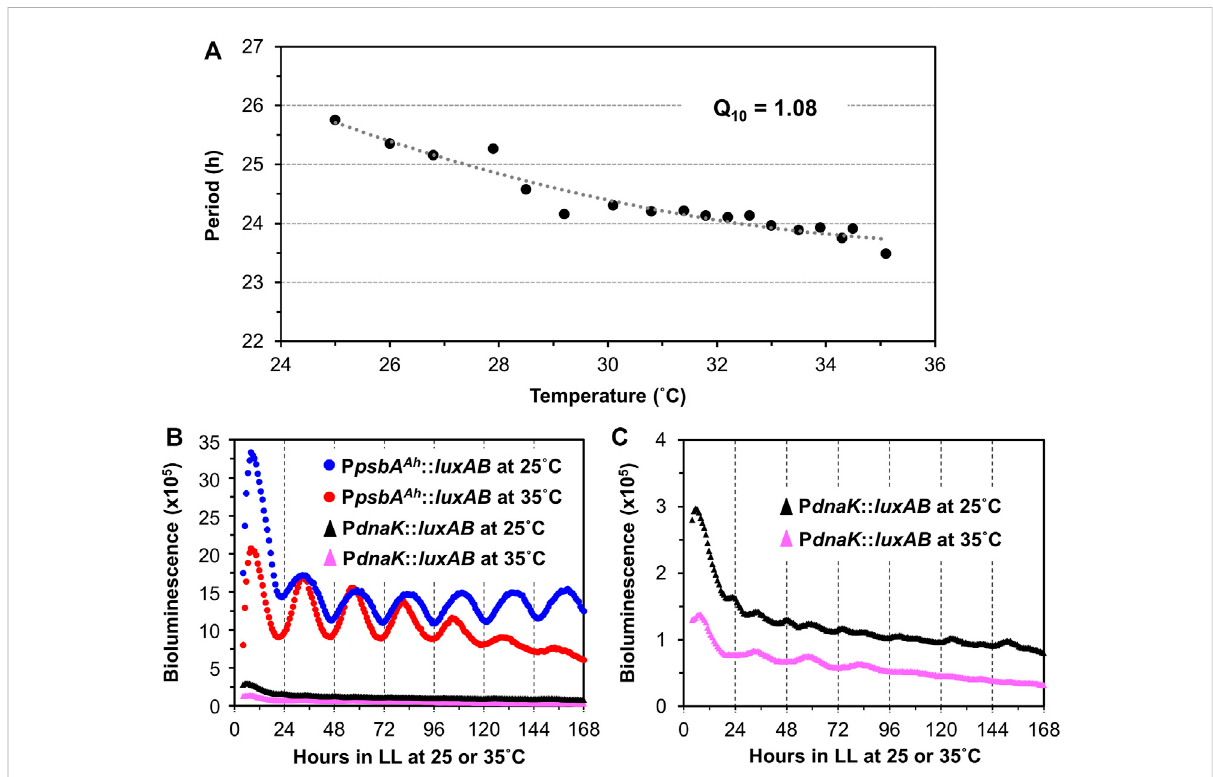
FIGURE 3 Temperature compensation of the P psbA Ah ::luxAB-driving luminescence rhythms in Synechocystis PCC 6803. (A) . Free-running periods (FRPs) and Q 10 value of the P psbA Ah ::luxAB reporter measured from WT Synechocystis colonies on Petri dishes containing agar medium at various temperaturesinLLbytheTaylortron.Q 10 wascalculatedasdescribedintheMaterialsandMethods. (B) .Comparisonofrepresentativeluminescence rhythms of the P psbA Ah ::luxAB and P dnaK ::luxAB reporters monitored in constant light at 25 ° C and 35 ° C with the Taylortron. (C). The same luminescence rhythms for the P dnaK ::luxAB reporter shown in panel B but on an expanded